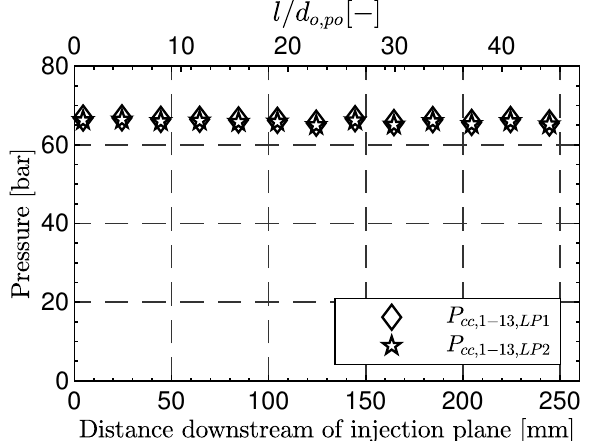
Figure 14. Pressure distribution in chamber downstream of injection plane.